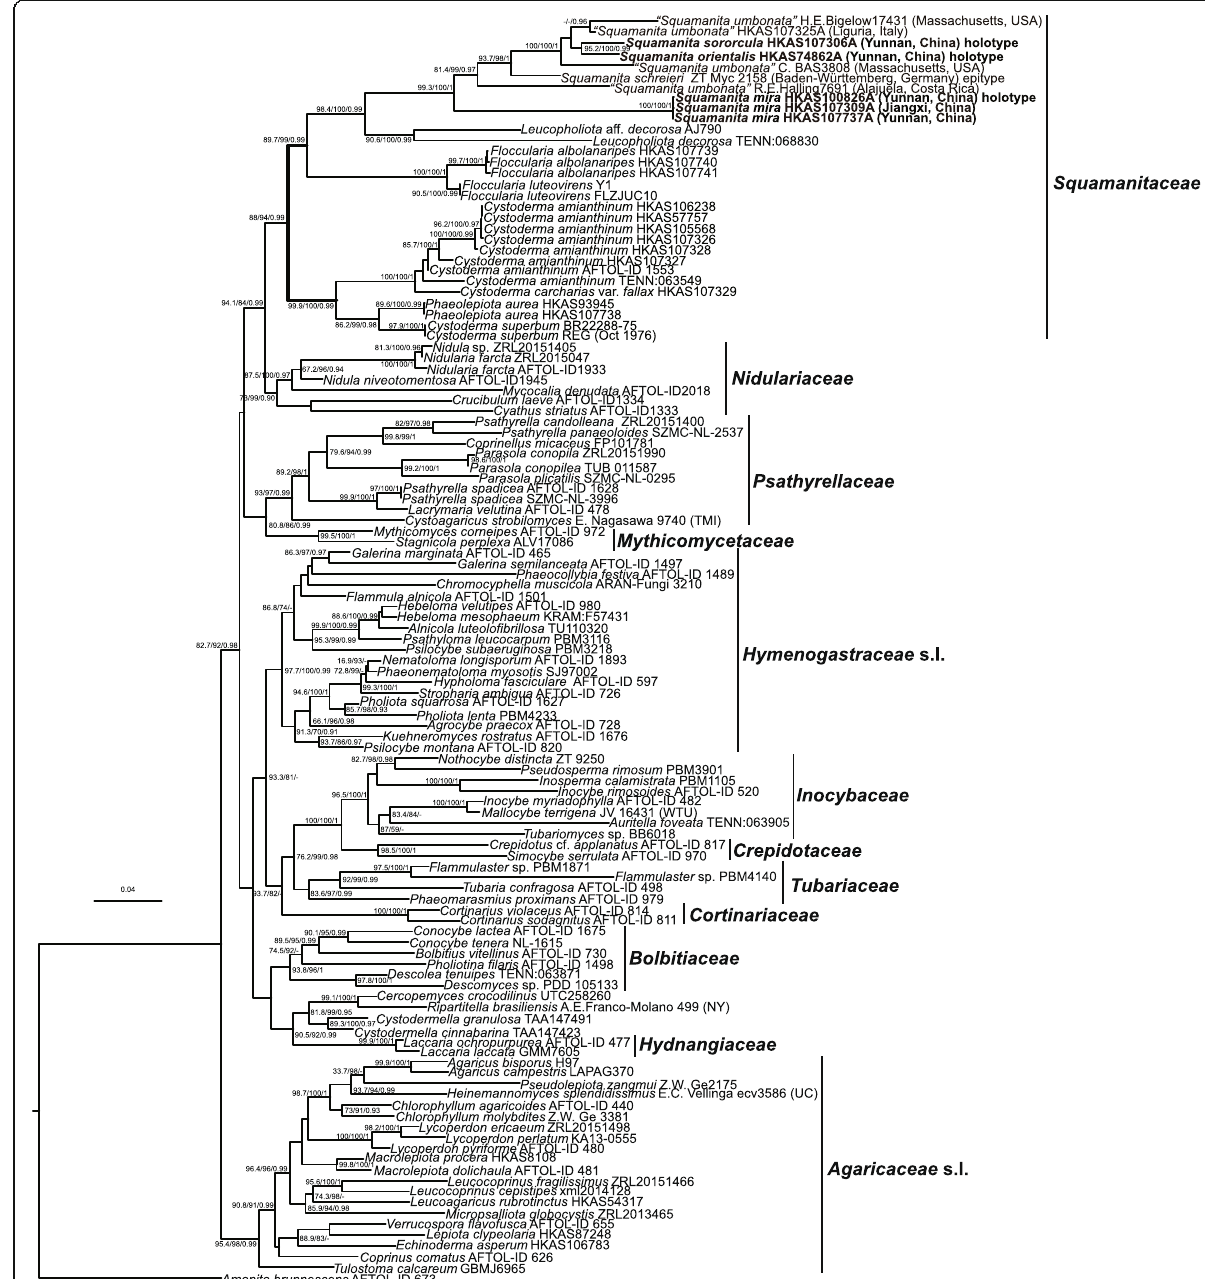
Fig. 2 Maximum-Likelihood (ML) phylogenetic tree of Squamanitaceae inferred from the 18S-5.8S-nrLSU-RPB2-TEF1 - α dataset, with SH-aLRT (left), ultrafast bootstrap (UFB) (middle), and PPs values (right) near by the corresponding node. Only one of SH-aLRT > 80 or UFB > 95 for ML and PPs > 0.90 for BI are indicated along branches (SH-aLRT/UFB/PP). New species Squamanita mira , S. orientalis , S. sororcula are